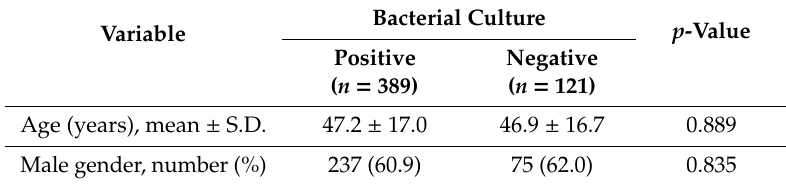
Table 1. Comparison of age and sex distribution according to the culture results.